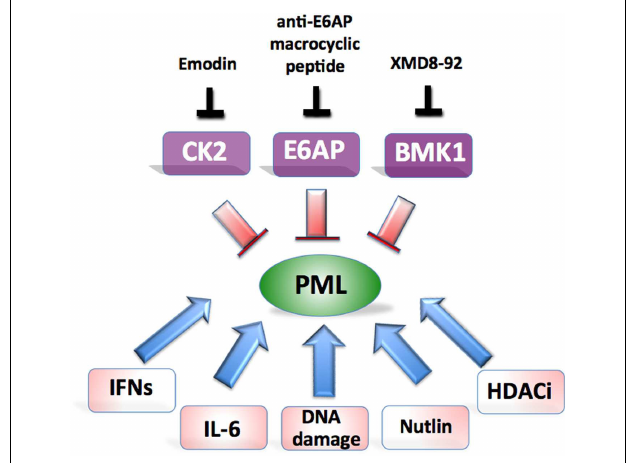
FIGURE 2 | Potential approaches aiming at restoration of PML-induced tumor suppression . Major therapeutic targets and their inhibitors are shown on top and potential combinatorial treatments at the